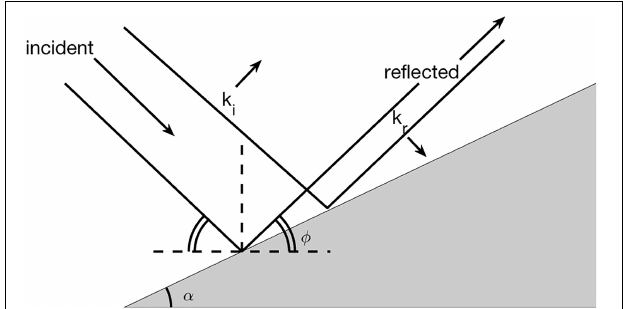
FIGURE 1 | Class #1: Ambient wave reflection. The key to understanding how the kinematic bottom boundary condition of no-normal flow changes the internal wave field over variable topography is contained in the internal wave dispersion relation. The internal wave frequency is determined not by wavelength, but rather by the angle of the wave vector with respect to the vertical, ϕ , and this determines the trajectories of water parcels. A simple visualization can be achieved by drawing the crests and troughs of a wave incident at the boundary and requiring that the reflected wave matches the propagation of these crests and troughs along the boundary (black solid lines). Depicted are incident and reflected wavenumbers k i and k r with phase propagating with the wavevectors. Wave frequency, and hence ϕ , are preserved under reflection, independent of the orientation of the slope, α . Transformation of incident energy to very high wavenumber k r occurs at a frequency for which ϕ ∼= α , leading to enhanced wave-breaking and mixing (e.g., Chalamalla et al., 2013). Figure after Garrett